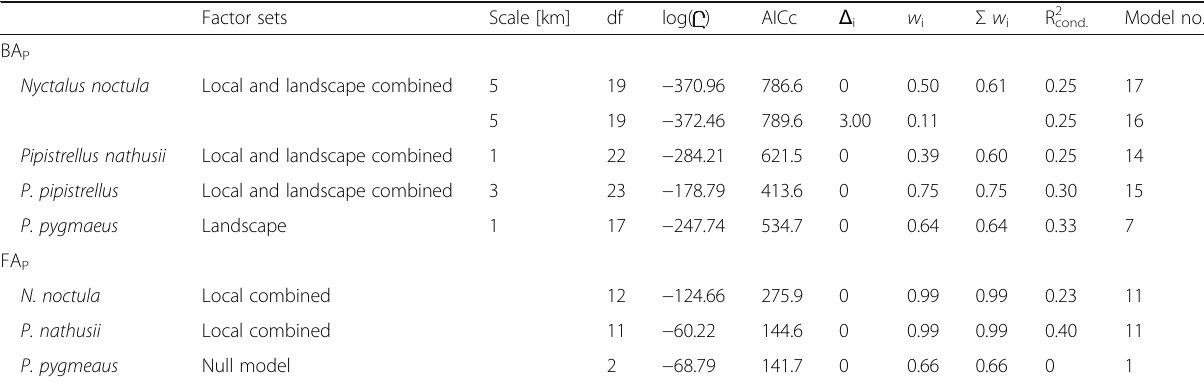
Table 2 Summary of the best generalized linear mixed effect models fitted to species-specific relative bat activity (BA P ) and foraging activity (FA P ) using the binomial error distribution. All 29 candidate models (see model no. in Table 1) were compared via AICc to identify the best model ( w i ≥ 0.9; w i is the weight of evidence of a model given the set of models; based on Burnham and Anderson (2002)). If no best model was found, we used the 90% confidence set of models for inference by summing up models from top to bottom until the accumulated number of weights reached w i = 0.9 ( Σ w i ). Here, we present only the most parsimonious models, so that Σ w i values are smaller than 0.9 (complete overview in Additional file